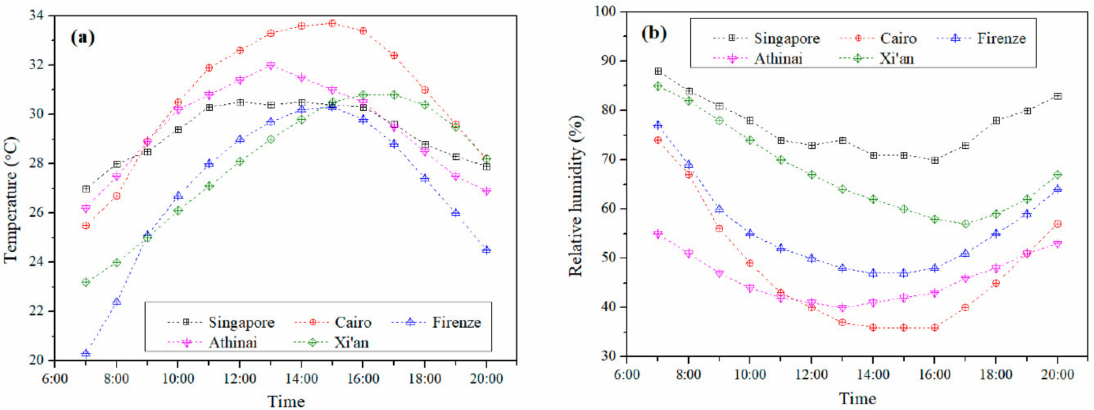
Figure 12. Hourly average ( a ) temperatures and ( b ) relative humidity for five cities evaluated. Reprinted with permission from Ref. [60]. Copyright 2019,